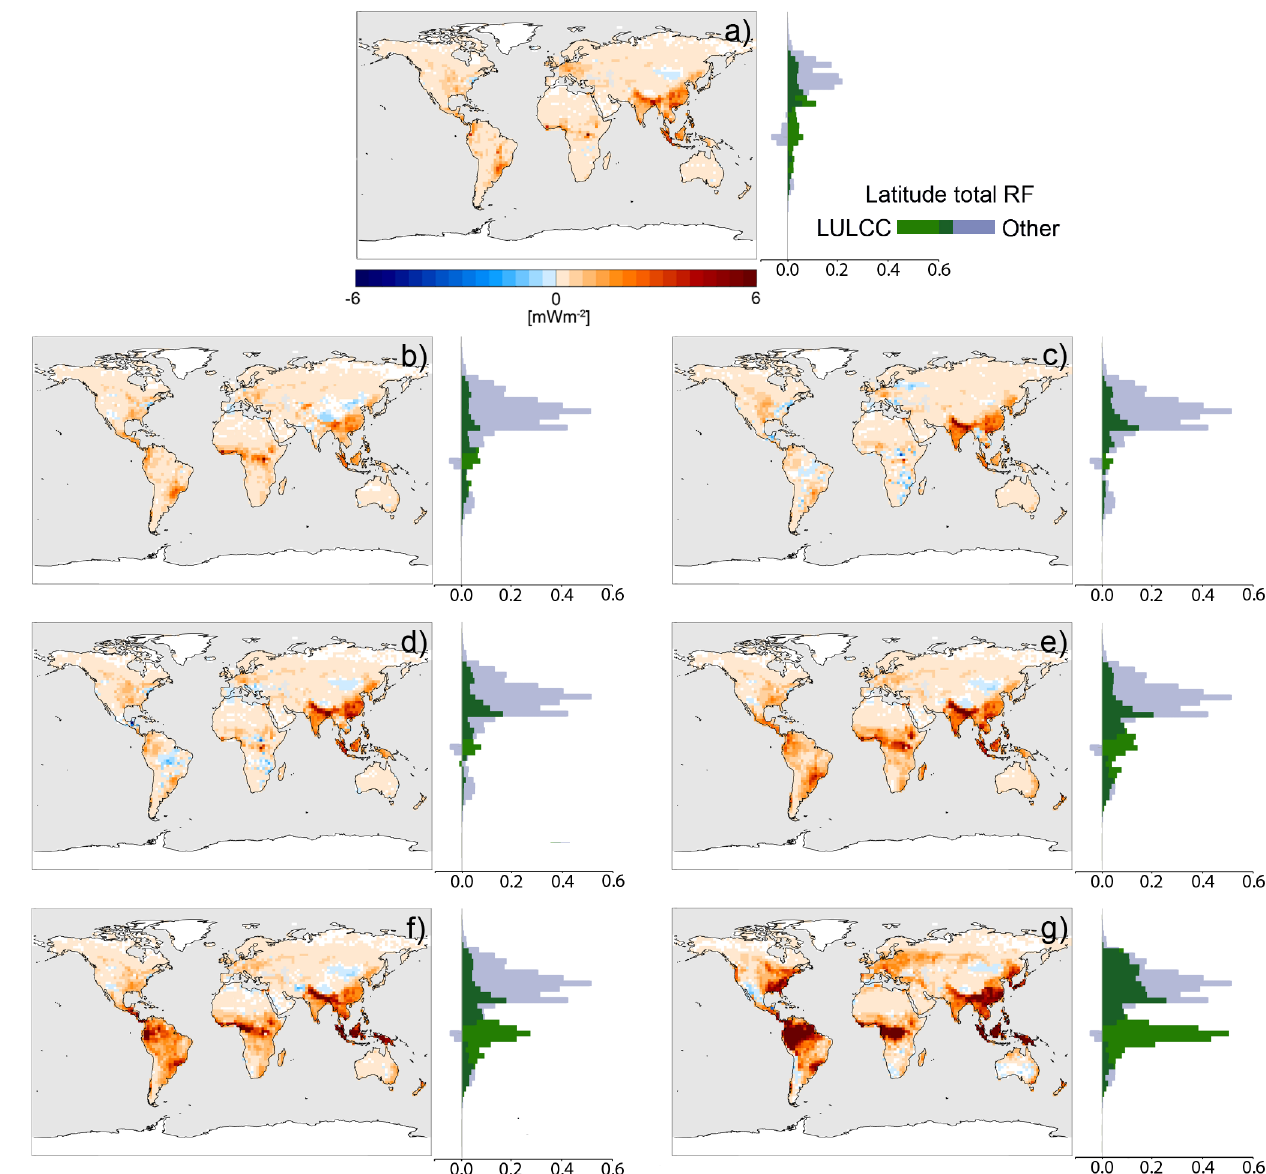
Figure 5. Spatial distribution of the sources of LULCC RF for (a) 2010, and the year 2100 given the projections of (b) RCP2.6, (c) RCP4.5, (d) RCP6.0, (e) RCP8.5, (f) trop-BAU, and (g) TEC. Latitude band total RFs are shown to the right of each spatial plot with the LULCC totals in green compared to the totals from other anthropogenic activities from (a) the year 2010, and (b–g) the year 2100 RCP4.5, in light